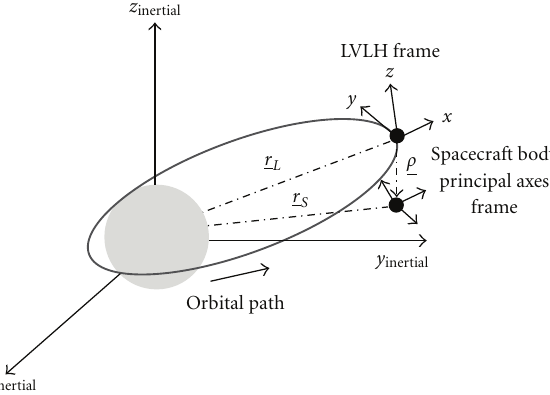
Figure 6: Local vertical local horizontal and inertial frames.